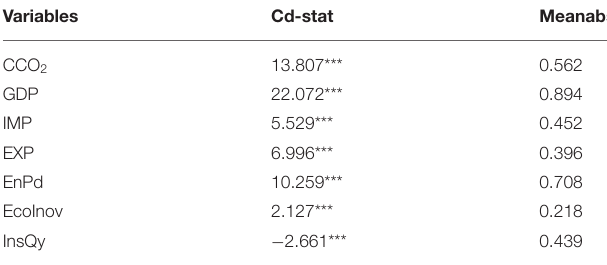
TABLE 2 | CD test